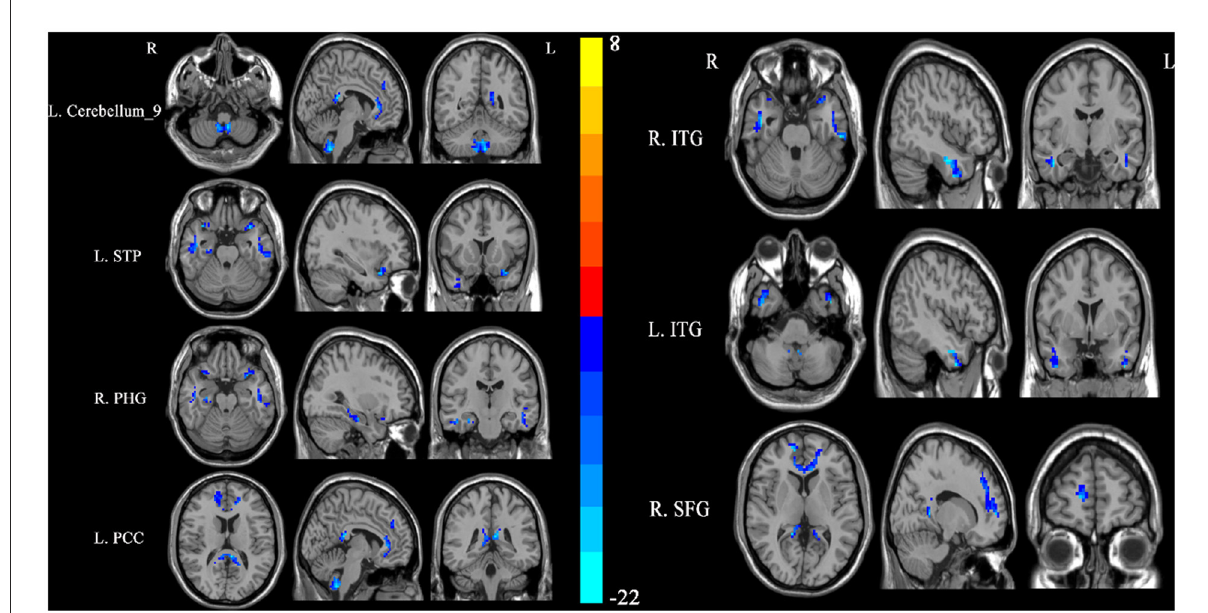
FIGURE1 Differences in regional homogeneity (ReHo) values between SSNHL patients and normal controls. Decreased ReHo values (left cerebellum, left STP, right PHG, left PCC, right SFG, and bilateral ITG) were presented on the blue color, and the color bar indicates the T values of the group analysis. L, left; R, right; STP, superior temporal pole; PHG, parahippocampal gyrus; PCC, posterior cingulum cortex; SFG, superior frontal gyrus; ITG, inferior temporal gyrus.